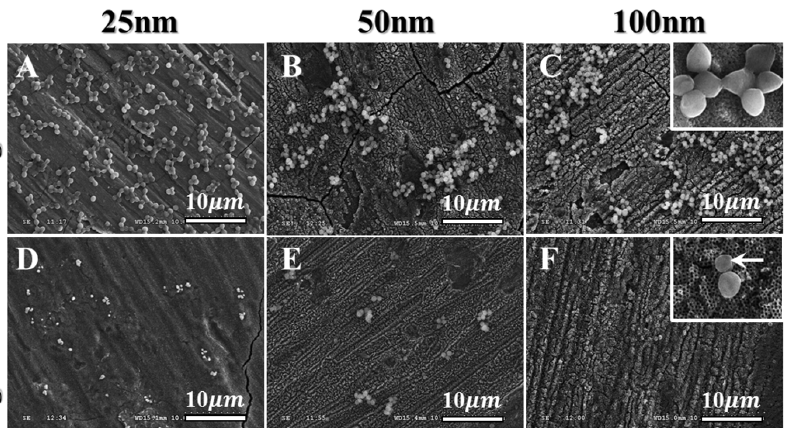
Figure 7. SEM images of S.aureus grown on as-grown or Ag-decorated TiO 2 nanotubes of different diameters. Numerous bacteria colonies on the as-grown nanotubes ( A–C ), while only a few bacteria can be seen on the Ag-decorated series ( D–F ).